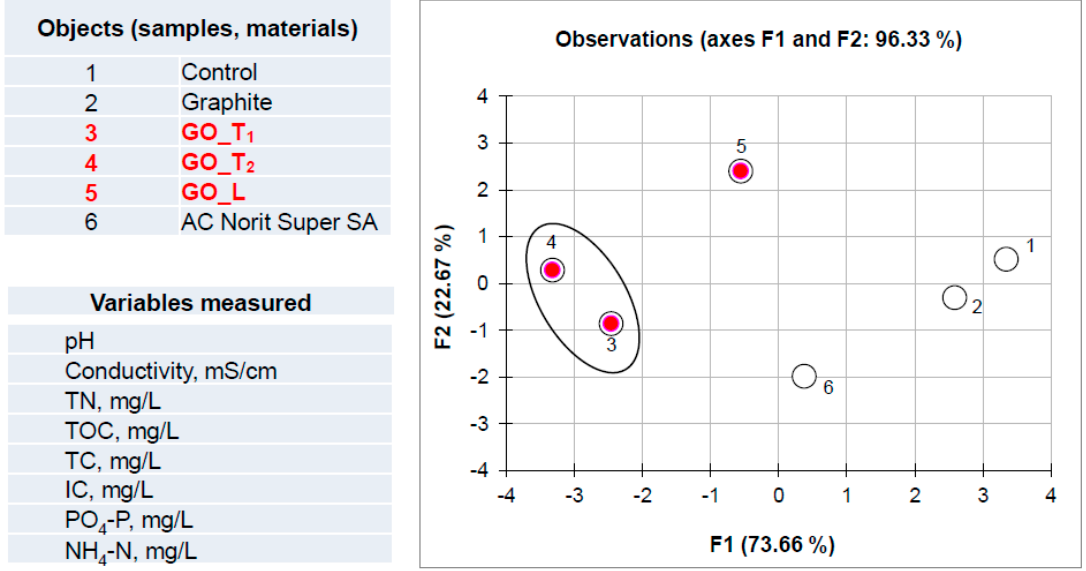
Figure 6. Results of principal component analysis (PCA) (F1/F2 factor scores plot) using matrix consisting of wastewater parameters measured (variables) after reaction (time 24 h) with selected carbon materials (objects).